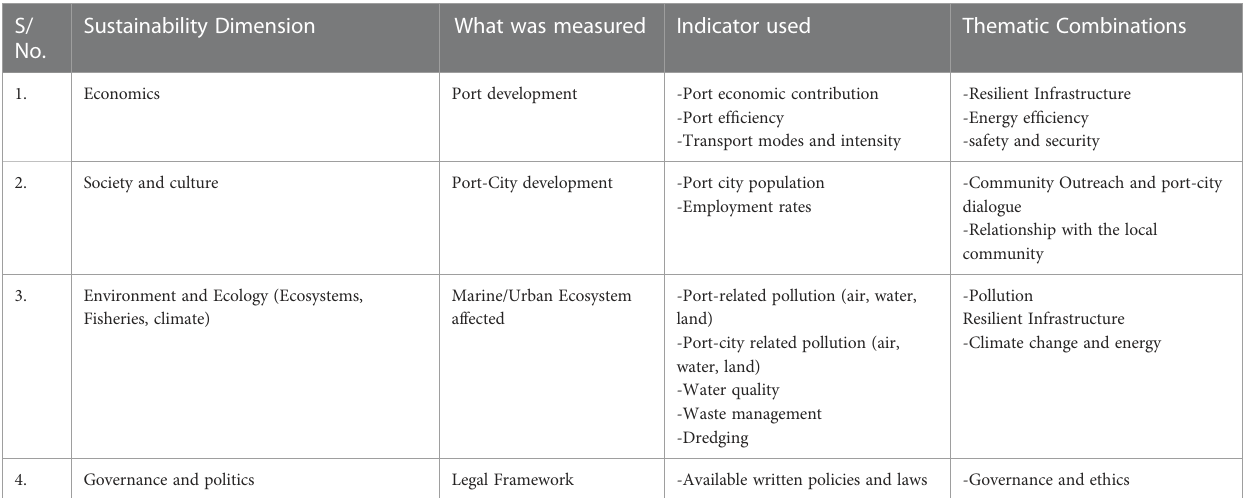
TABLE 4 Parameters and Indicators Measured.